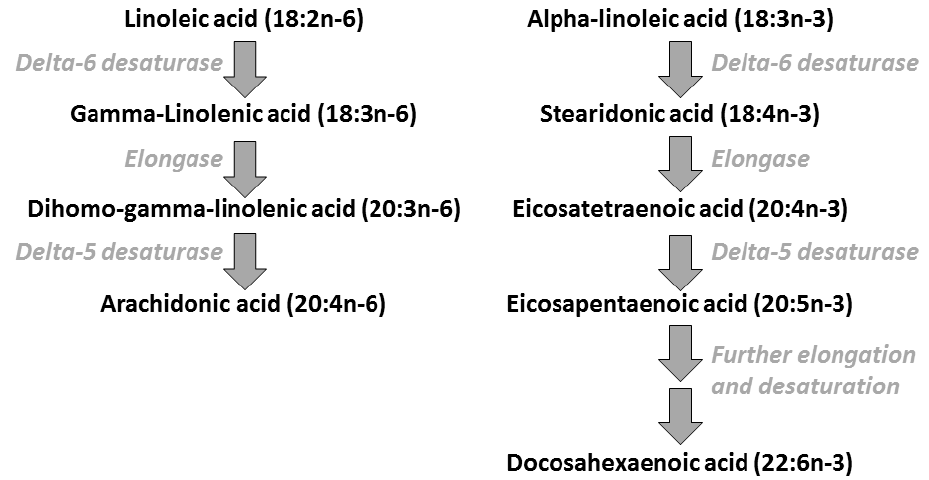
Figure 1. Overview of the pathway of conversion of linoleic and α -linolenic acids to longer chain more unsaturated n -6 and n -3 polyunsaturated fatty acids (PUFAs).